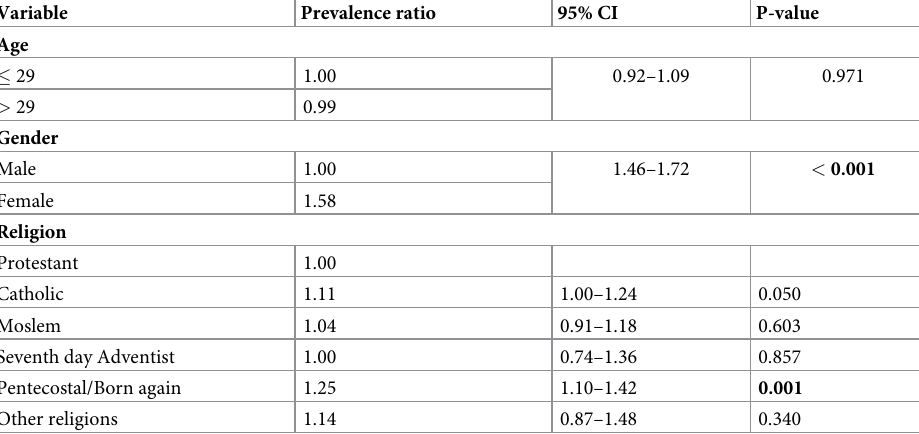
Table 4. Multivariate analysis of the association between FEP and selected